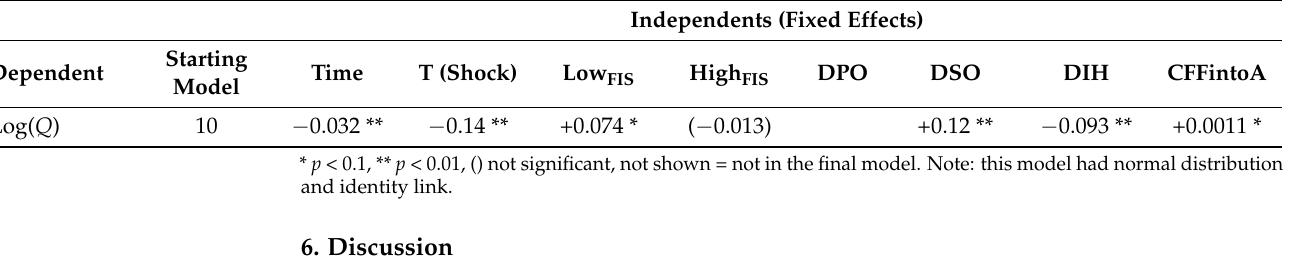
Table 6. Model-based results from the model 10 which had normal distribution and identity link. The coefficients for fixed effects shown are for the final model that only includes significant coefficients. The sector and region were included as random effects that cannot be generalized (coefficients not shown). It appears that there is a slight negative trend, the shock had a negative effect, financially strong firms perform better, longer DSO and smaller DIH result in better performance and DPO has no